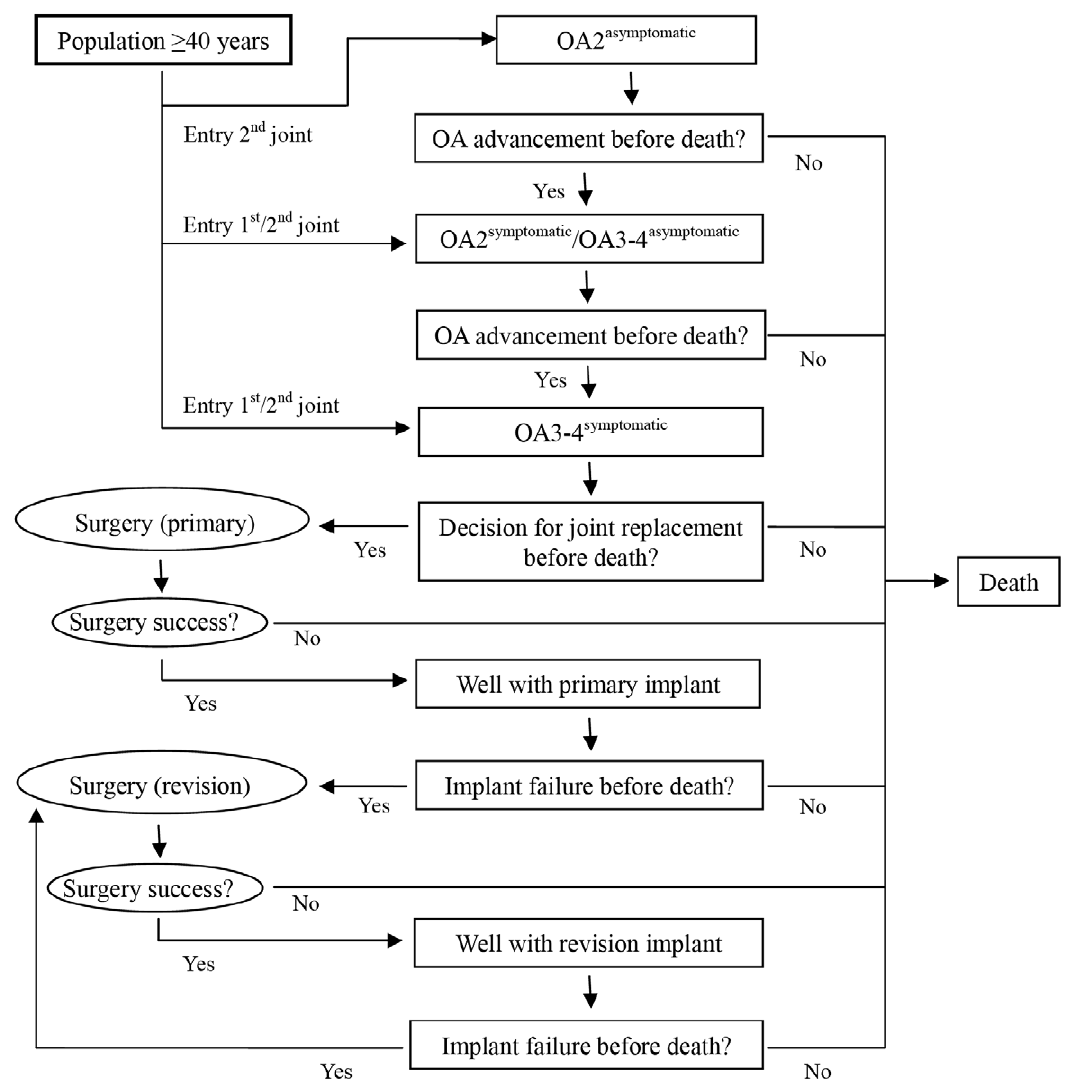
Figure 1. Event pathway of people with osteoarthritis in the discrete-event simulation model.